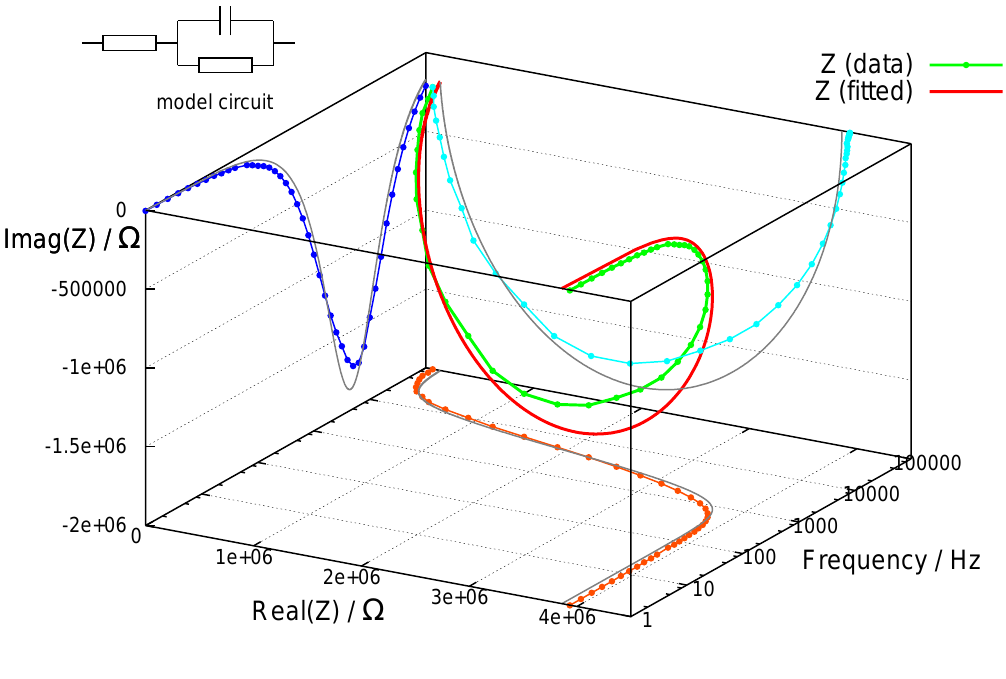
Figure 6 . Impedance spectrum of a conventional AC-El cell at low voltage, together with fitted